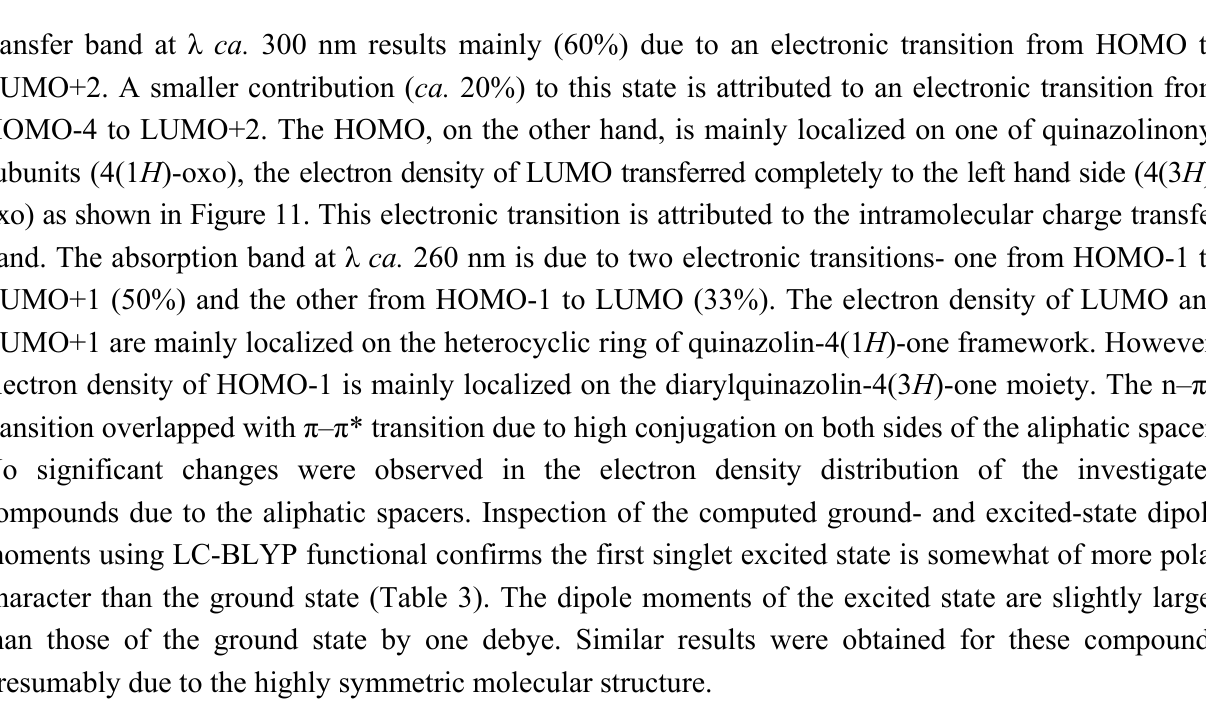
Figure 10. Computed absorption spectra of 4c , 4e and 4i